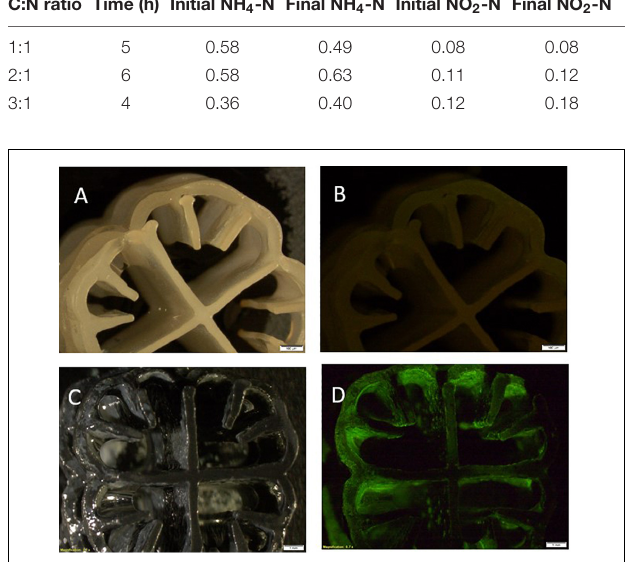
FIGURE 6 | Photograph of polyethylene biocarrier containing biomass of Acinetobacter EMY as a biofilm. Photographs through a microscope: (A) Sterile biocarrier without staining; (B) Sterile biocarrier with fluorescent staining; (C) Biofilm on biocarrier without staining; (D) Biofilm on biocarrier with fluorescent